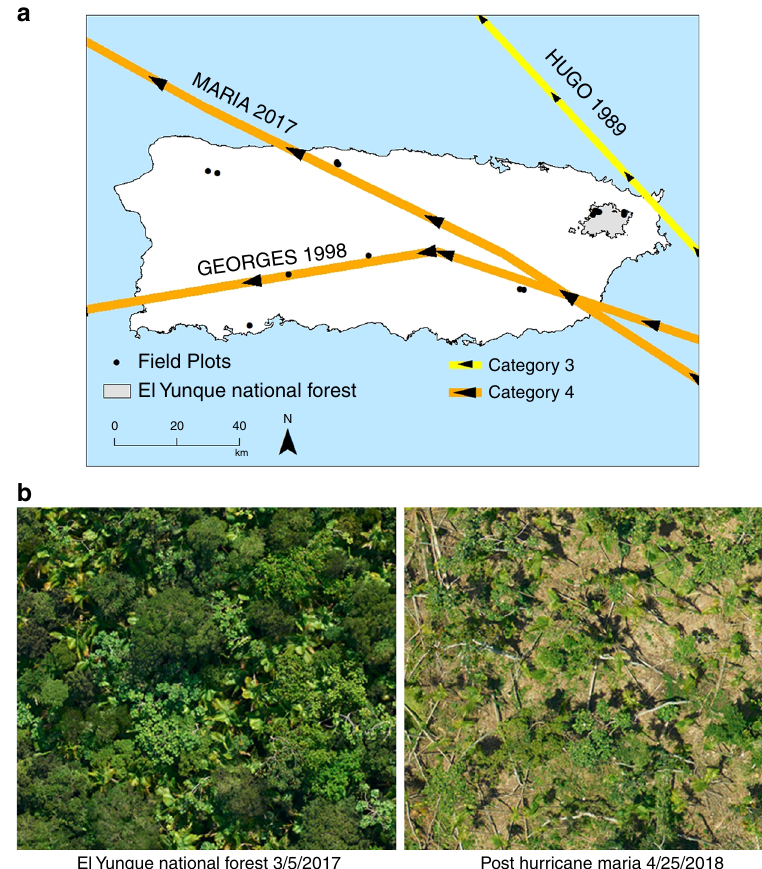
Fig. 1 Tracks of Hurricanes Hugo, Georges, and María ( a ); and aerial photographs of the study area in El Yunque National Forest before and after Hurricane María ( b ). Images courtesy of D. Morton,